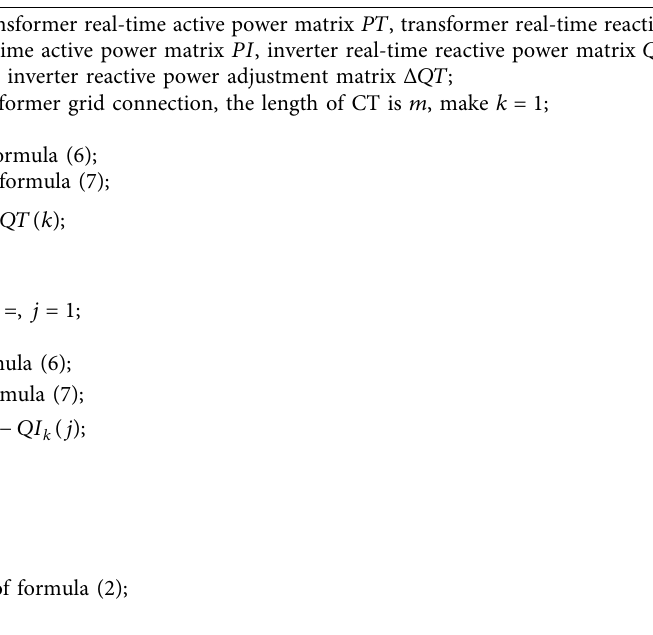
Table 6: Angle length distributed algorithm of multidimensional dynamic capacity. Algorithm 3: Angle length distributed